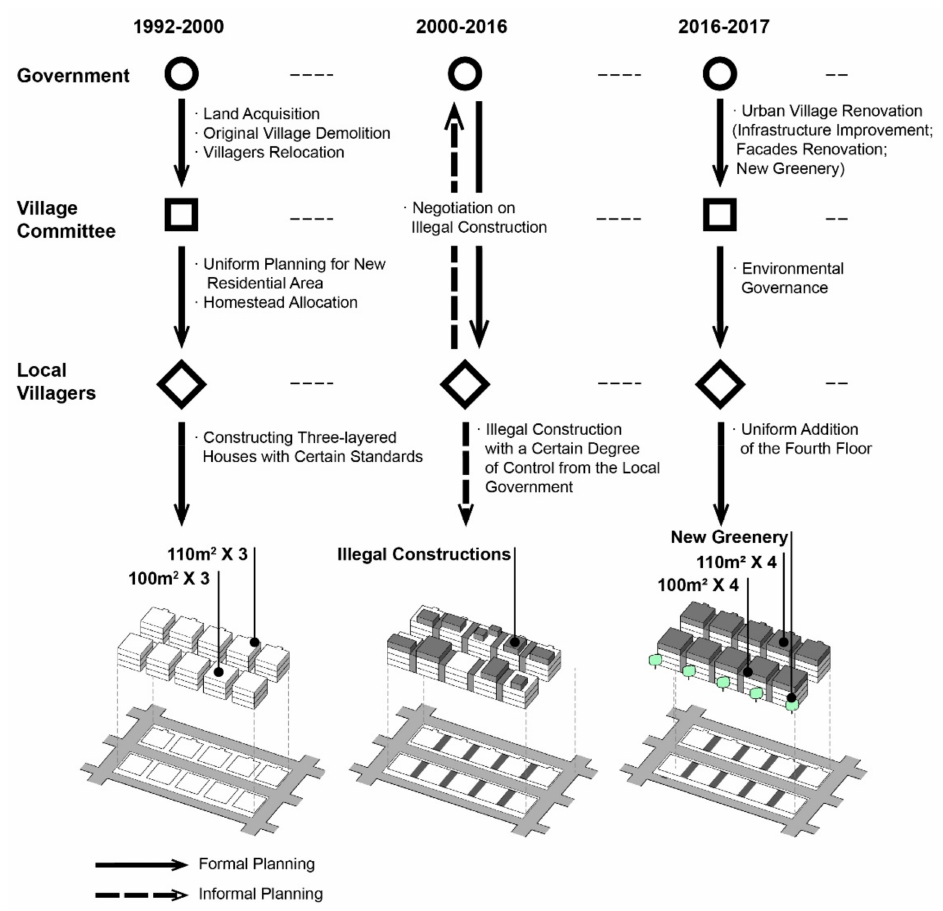
Figure 7. Planning and construction process of